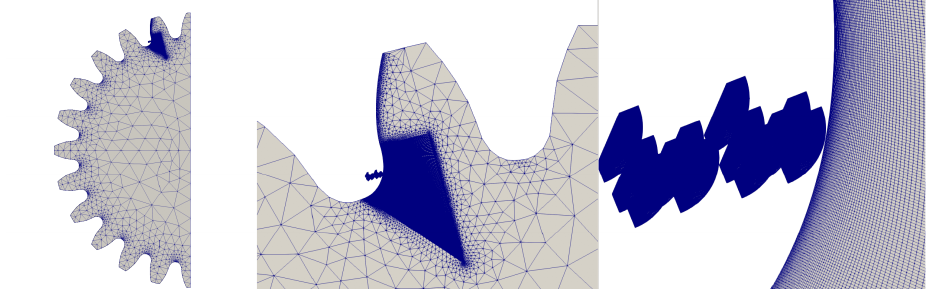
Figure 1. Mesh: about 1M second-order wedge